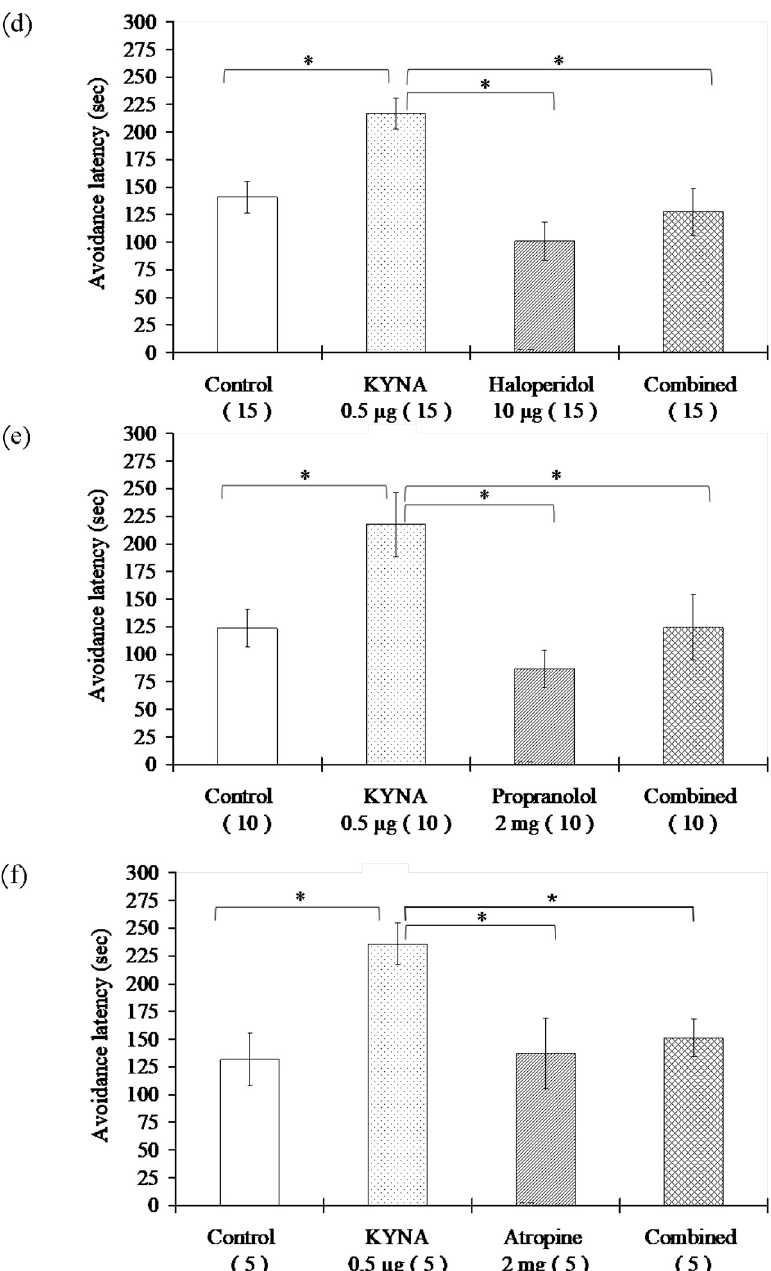
Figure 3. ( a – c ) The effects of different receptor blockers and their interaction with KYNA treatment in mice in the passive avoidance test: Cyproheptadine , a nonselective 5-HT2 serotonergic receptor antago- nist ( a ); phenoxybenzamine , a nonselective α -adrenergic receptor antagonist ( b ); naloxone , a nonselective opioid receptor antagonist ( c ); * p < 0.05, the data in the plots are presented as means ± SEM. The exact subject numbers per group are indicated in brackets below the corresponding bar in the plots. ( d – f ) The effects of different receptor blockers and their interaction with KYNA treatment in mice in the passive avoidance test. Haloperidol , a D2, D3, D4 dopamine receptor antagonist ( d ); propranolol , a nonselective β -adrenergic receptor antagonist ( e ); and atropine , a nonselective muscarinic acetyl- choline receptor antagonist ( f ); * p < 0.05, the data in the plots are presented as means ± SEM. The exact subject numbers per group are indicated in brackets below the corresponding bar in the